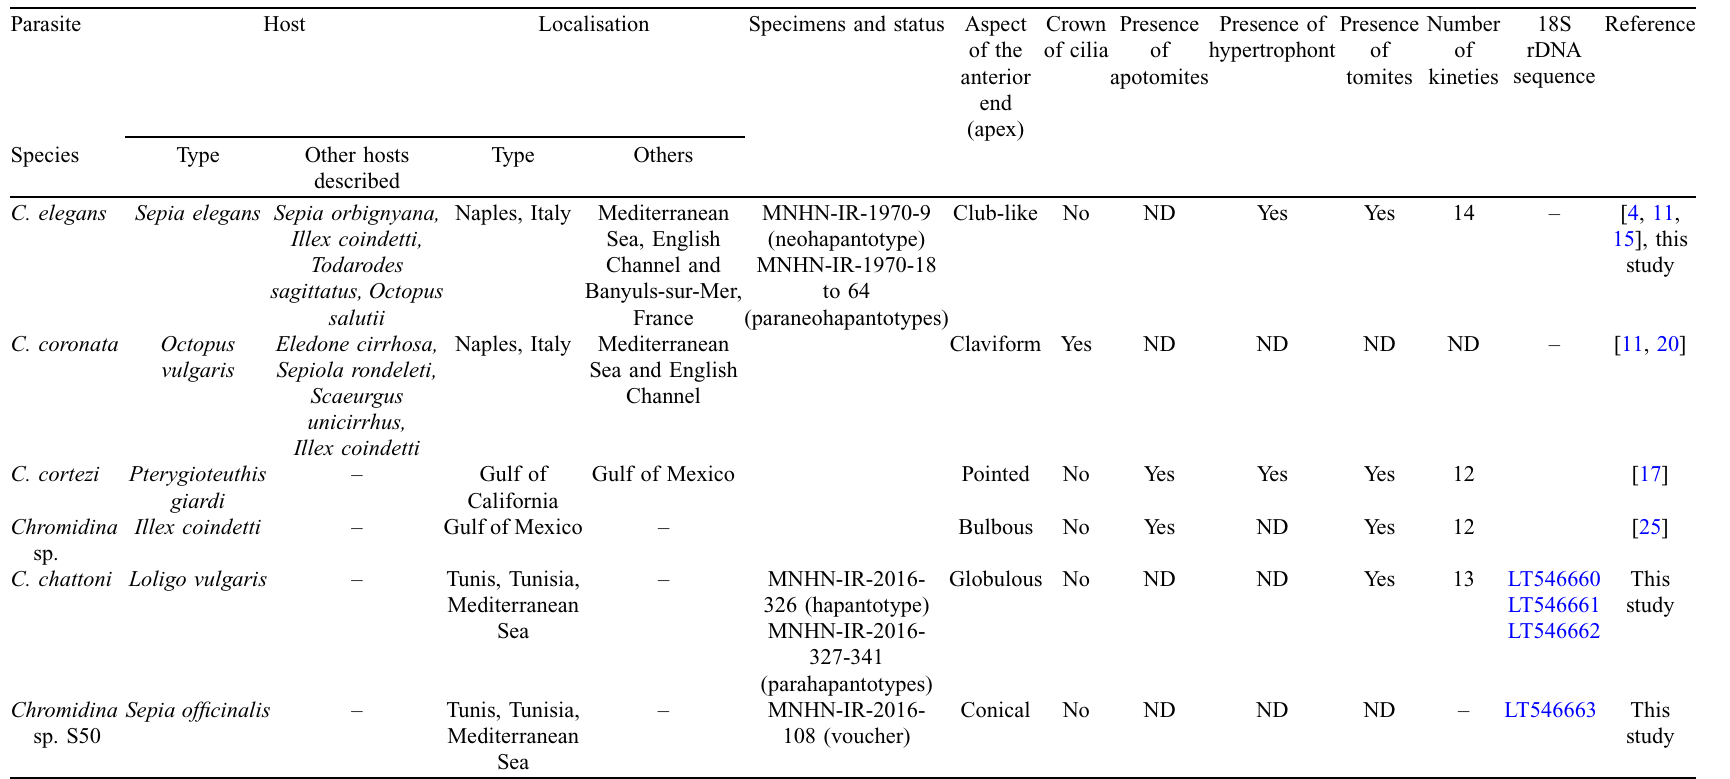
Table 1. Summary of morphological features of Chromidina species.